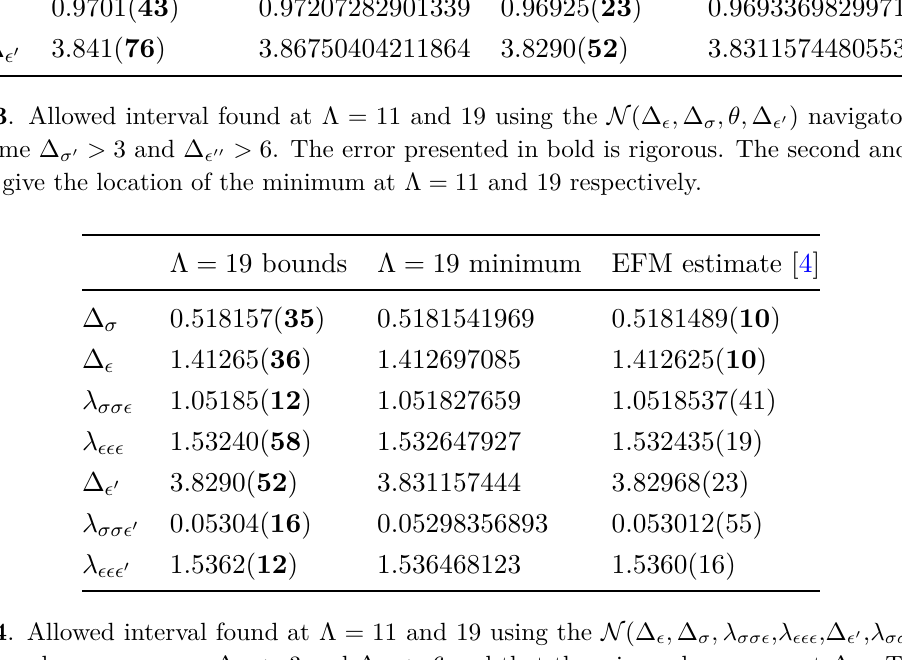
. The error (cid:15) 0